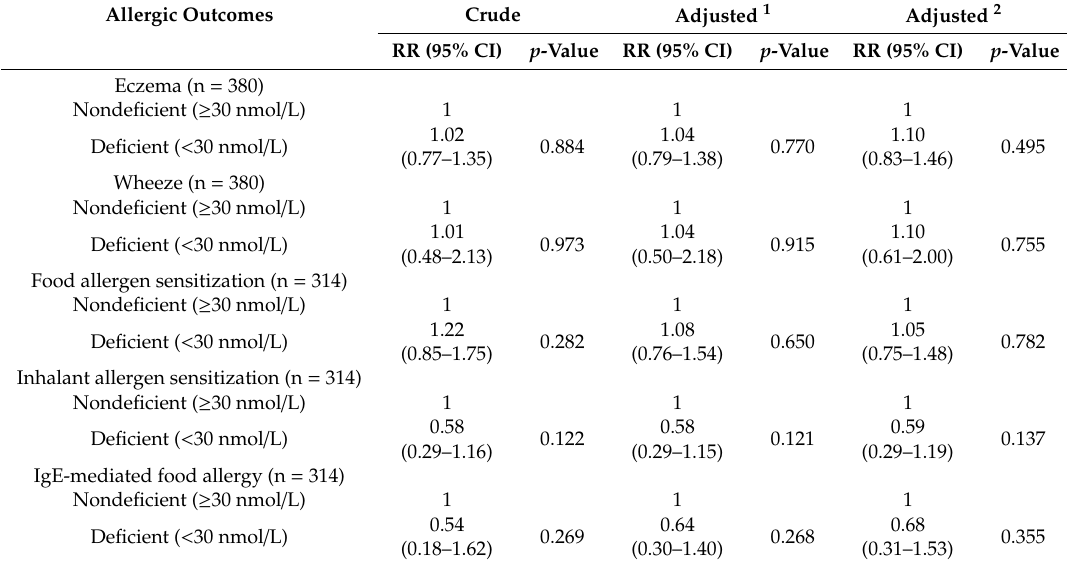
Table 3. Associations between maternal 25(OH)D levels and allergic diseases in infants during the first year of